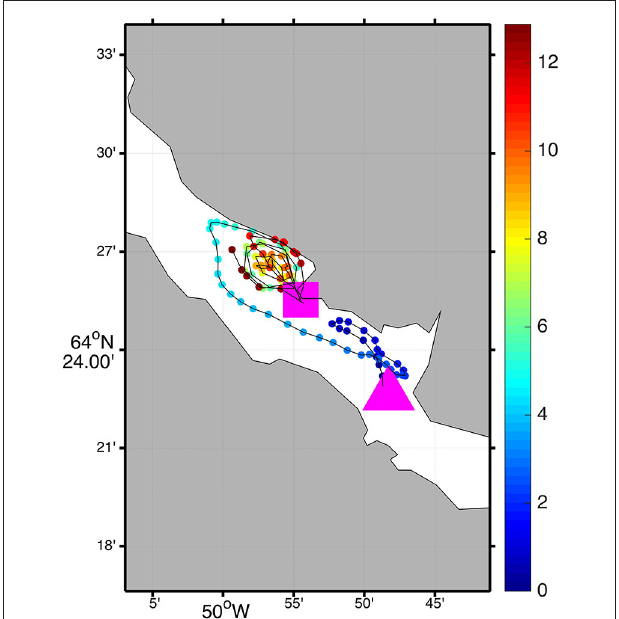
FIGURE 4 | A trajectory of an EXITE beacon initially deployed at the large pink triangle. Locations are color-coded according to time, in days, since deployment. Every 4th measurement is shown for clarity. The location where the critical acceleration was exceeded is indicated by the large pink square.